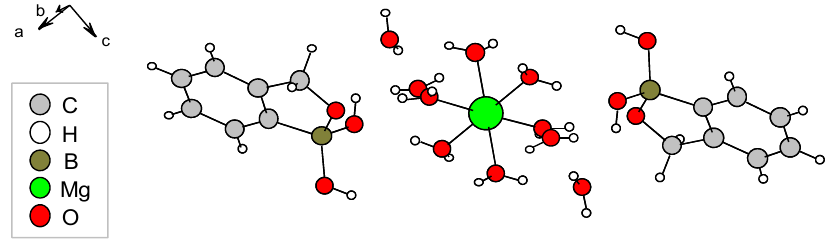
Figure 7. Coordination environment of Mg 2+ in the Mg-benzoxaborolate decahydrate phase, showing that the metal cation is linked to 6 water molecules, while the benzoxaborolate anions balance the charge [27].